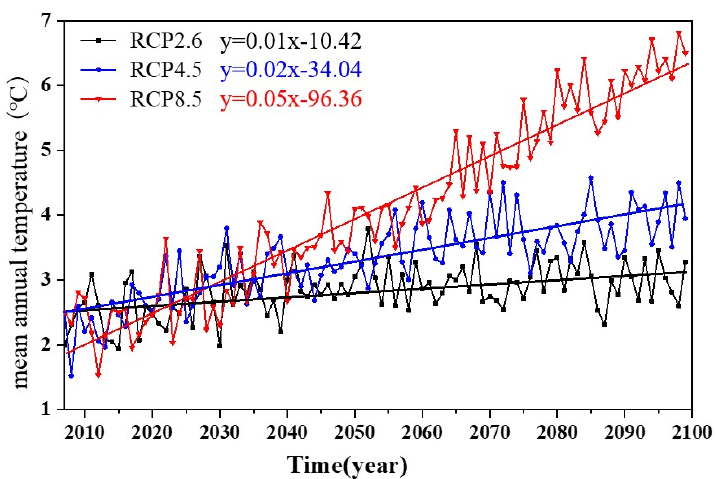
Figure 3. The future changes in temperature at different scenarios in the upper Taohe River Basin. At the same time, the possible future temperature changes in this basin are also ana- lyzed from the two aspects of maximum and minimum temperatures. The annual average maximum and minimum temperature changes in the upper and middle reaches of the Taohe River under the three greenhouse gas emission scenarios were set for four stages: 2007–2018 and the 2020s (2019–2039), 2050s (2040–2079), and 2080s (2080–2099) (Figure 4). Figure 4. The future changes in the maximum and minimum temperatures under different scenar- ios. The maximum temperature and minimum temperature show increasing trends un- der the three scenarios. The change in the maximum temperature under the RCP2.6 sce- nario increases steadily, and the increments in the three stages would be 0.13 °C, 0.44 °C, and 0.44 °C higher than those from 2007 to 2018, which is consistent with the change trends in the average temperature. Under the RCP4.5 scenario, the maximum temperature would increase significantly, and the temperature could be 0.63 °C, 1.02 °C, and 1.42 °C higher than in 2007–2018, under the three scenarios, with a maximum change range of 13– 17%. The future maximum temperature shows significant changes under the RCP8.5 sce- nario, which would increase to 0.49 °C, 1.64 °C, and 3.34 °C, which could be higher than the temperature in 2007–2018, with a maximum range of 33%. The results indicate that the high- est temperature in the 21st century would increase gradually. RCP2.6